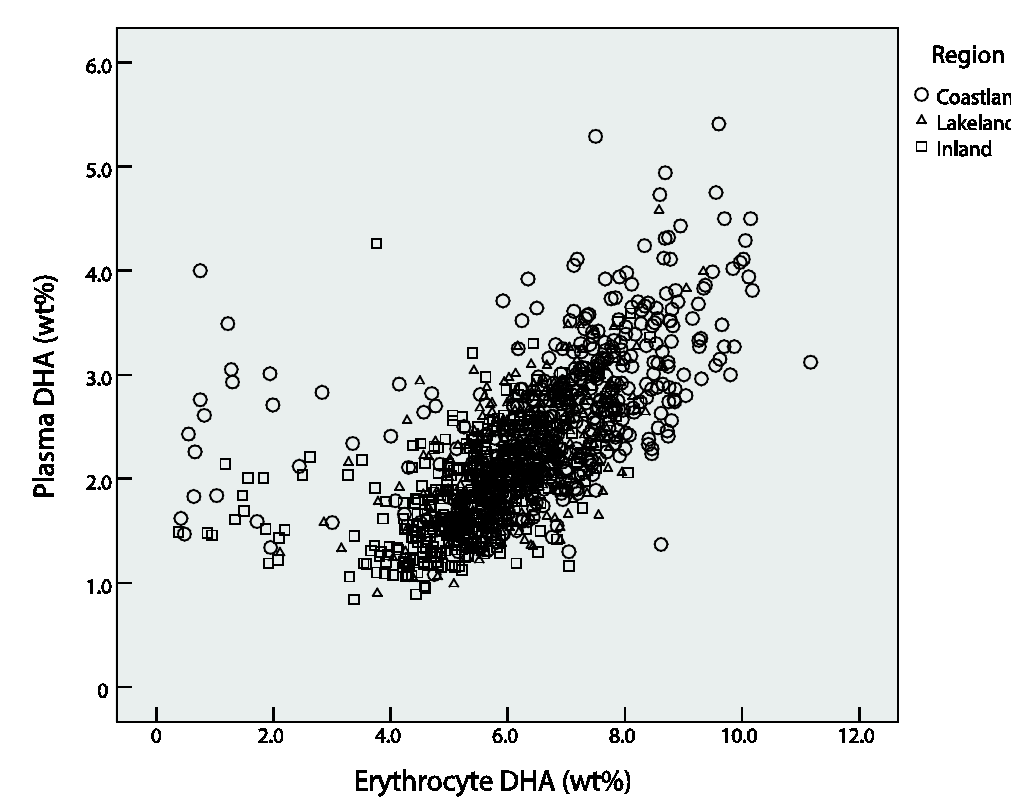
Figure 1. Correlation between plasma and erythrocyte DHA relative concentrations in 1211 participants.